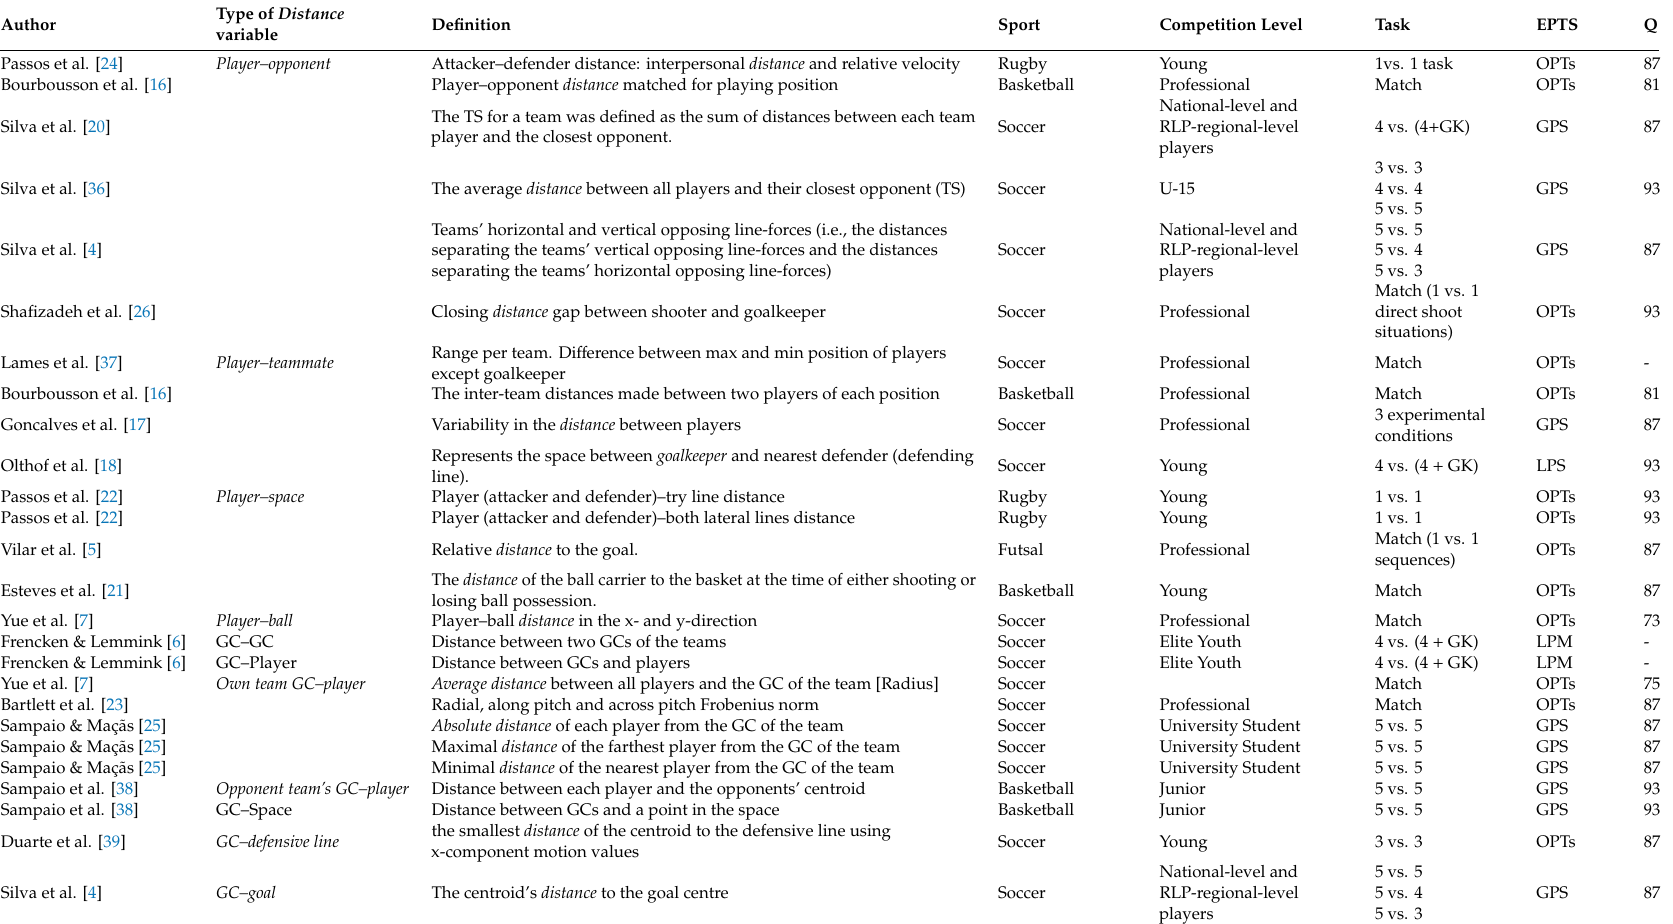
Table 2. Origin and modifications of the distance